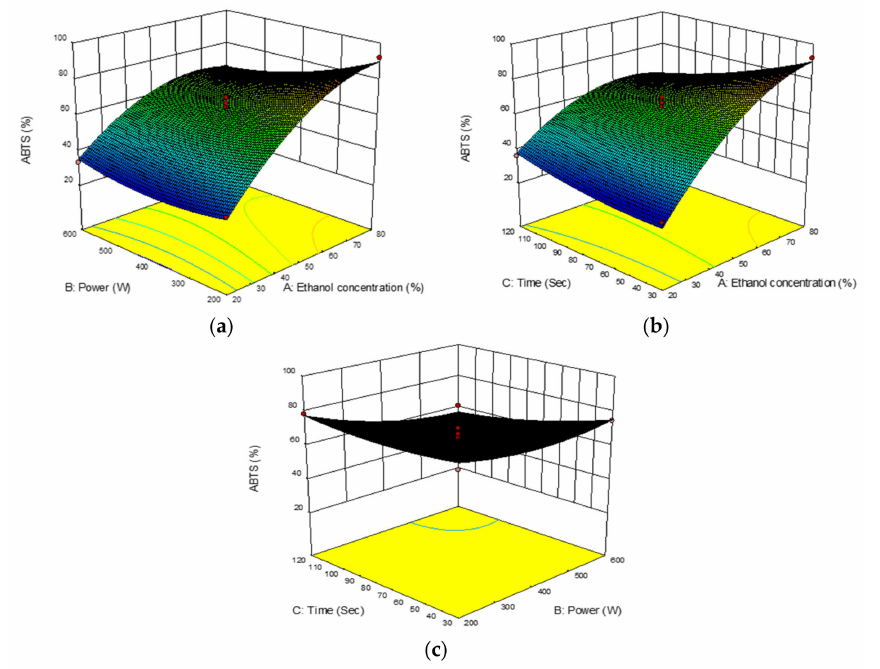
Figure 5. Response surface analysis (3D) for Barleria lupulina Lindl. leaf extract (BLLE) on ABTS activity: ( a ) effect of ethanol concentrations and microwave power; ( b ) effect of ethanol concentrations and extraction time; ( c ) effect of microwave power and extraction